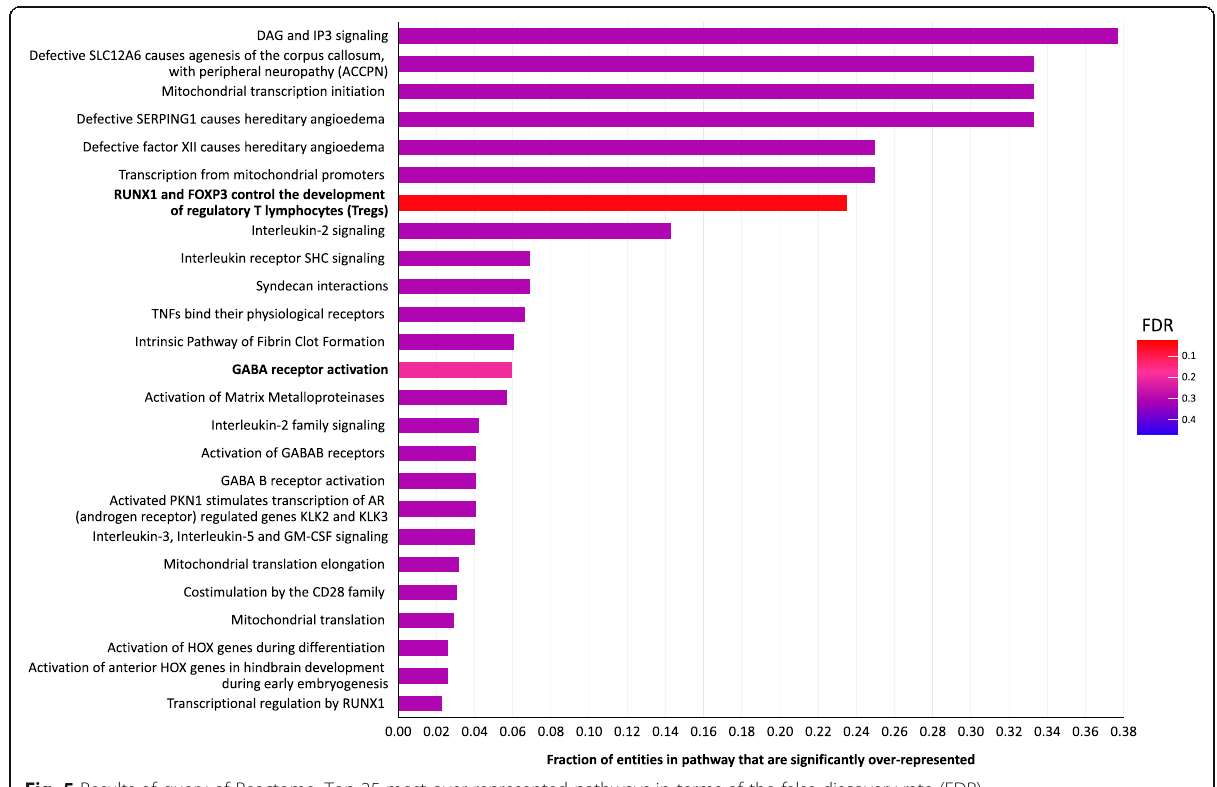
Fig. 5 Results of query of Reactome. Top 25 most over-represented pathways in terms of the false discovery rate